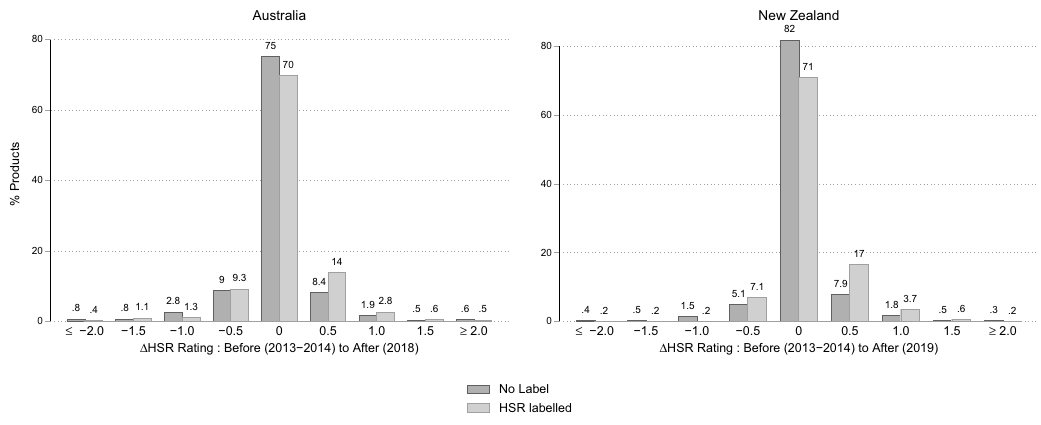
Fig 2. Percent of products by change in imputed HSR rating before HSR implementation (2013–2014) versus the last year observed after adoption (2018 for Australia and 2019 for NZ). HSR, Health Star Rating; NZ, New Zealand.